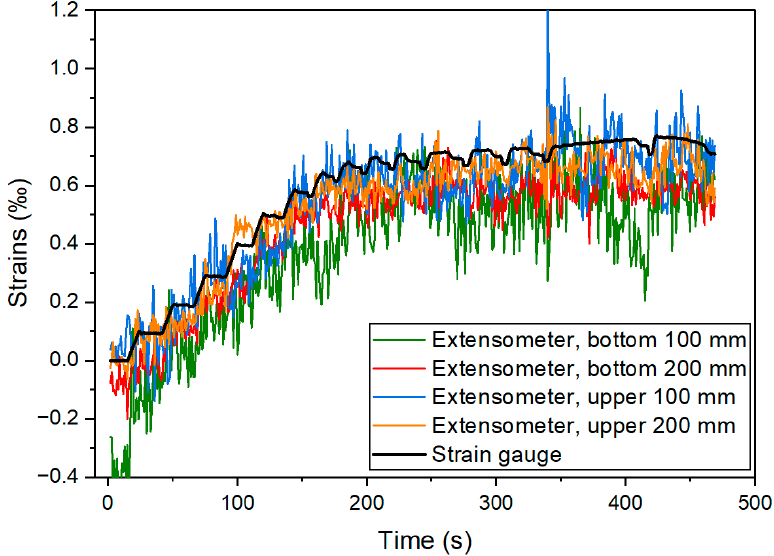
Figure 24. Comparison of the strain measurements in the plastic range in the β‐β section.